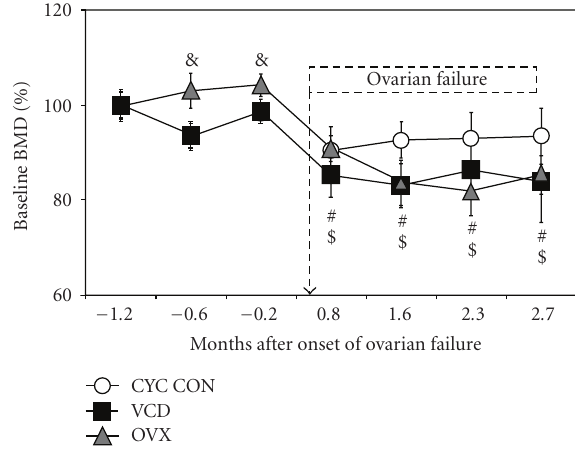
Figure 1: Temporal changes in lumbar BMD in aged mice.